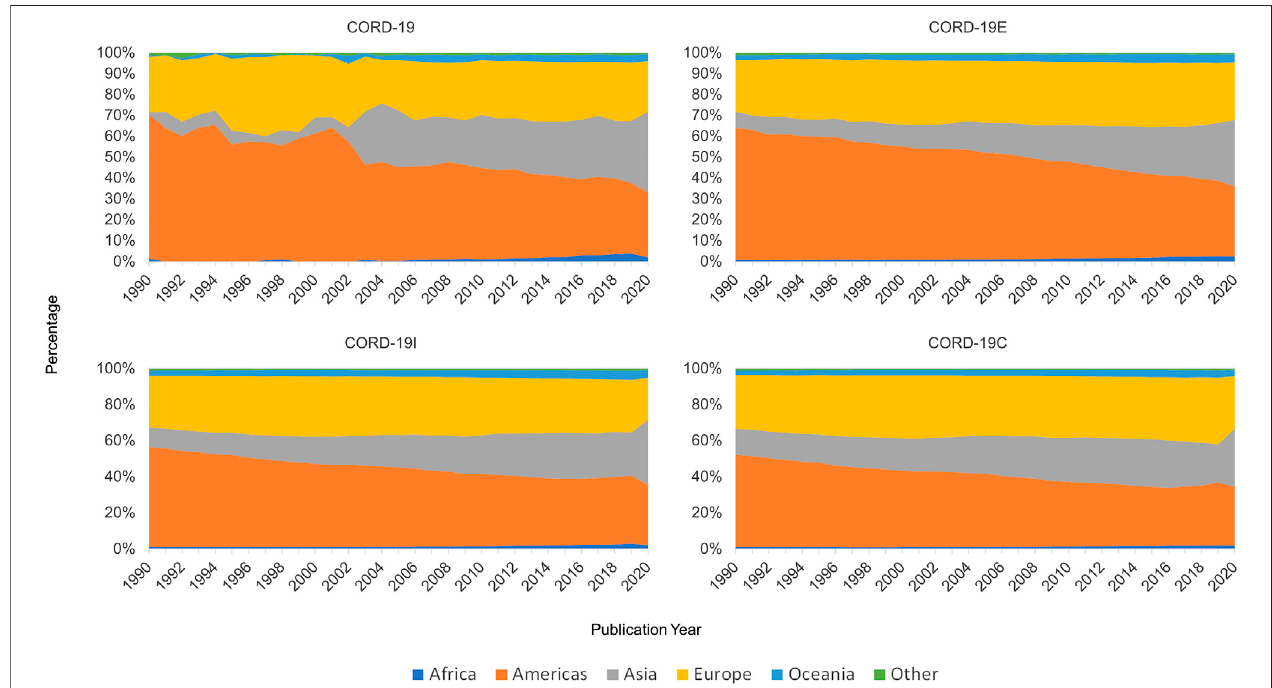
FIGURE 10 | Geopolitical distribution of articles by year for COVID-19 Research Dataset (CORD-19) and the three expanded datasets.